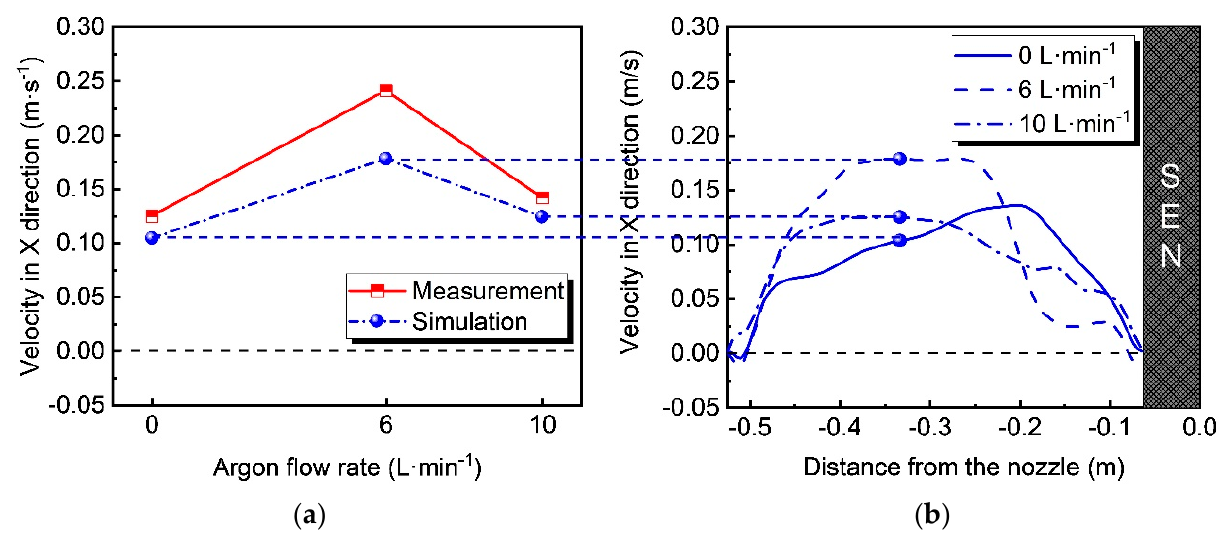
Figure 5. Comparison of the calculated and measured velocities of molten steel near the mold surface under the different argon flow rates. ( a ) Comparison between the calculated and measured velocities; ( b ) calculated results.